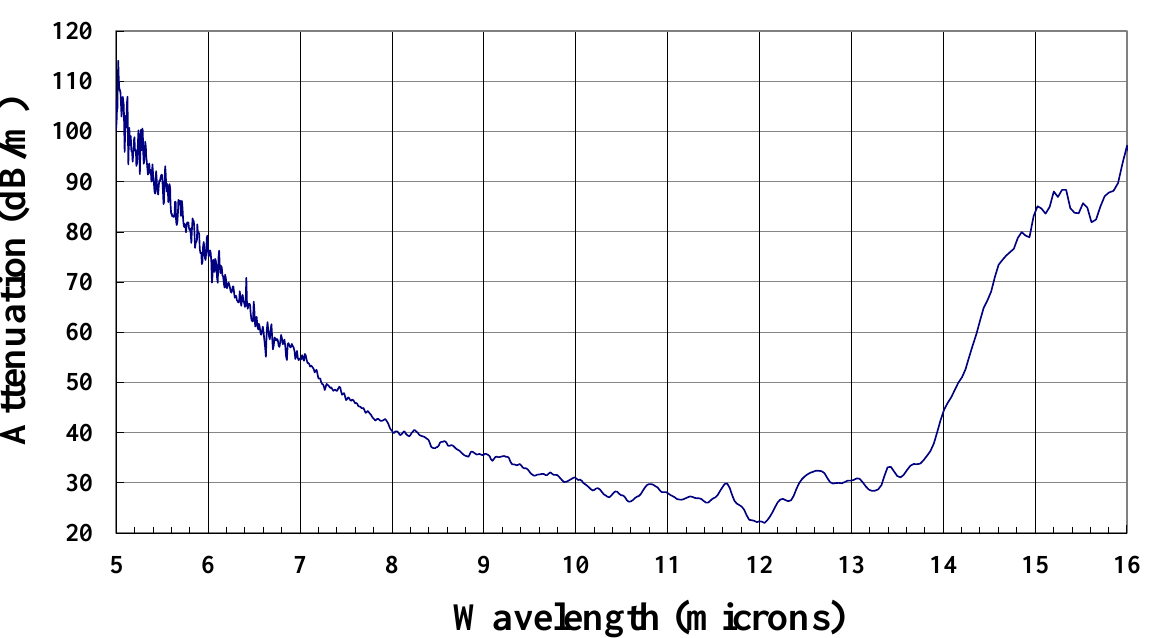
Te I glass fiber showing minimum loss around 19.8 79.2 1